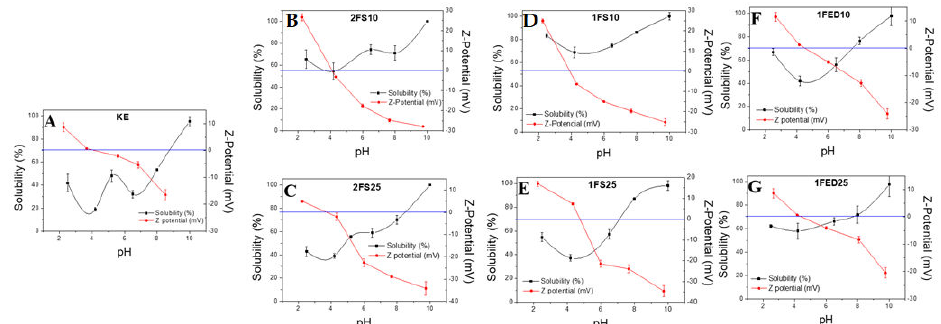
Figure 7. Solubility and Z-potential of the different keratin proteins extracted and functionalized: ( A ) keratin extracted; ( B , C ) keratin extracted and functionalized with succinic anhydride at 10% and 25% in two stages; ( D , E ) keratin extracted and functionalized with succinic anhydride at 10% and 25% in one stage; ( F , G ) keratin functionalized with EDTAD at 10% and 25% in one